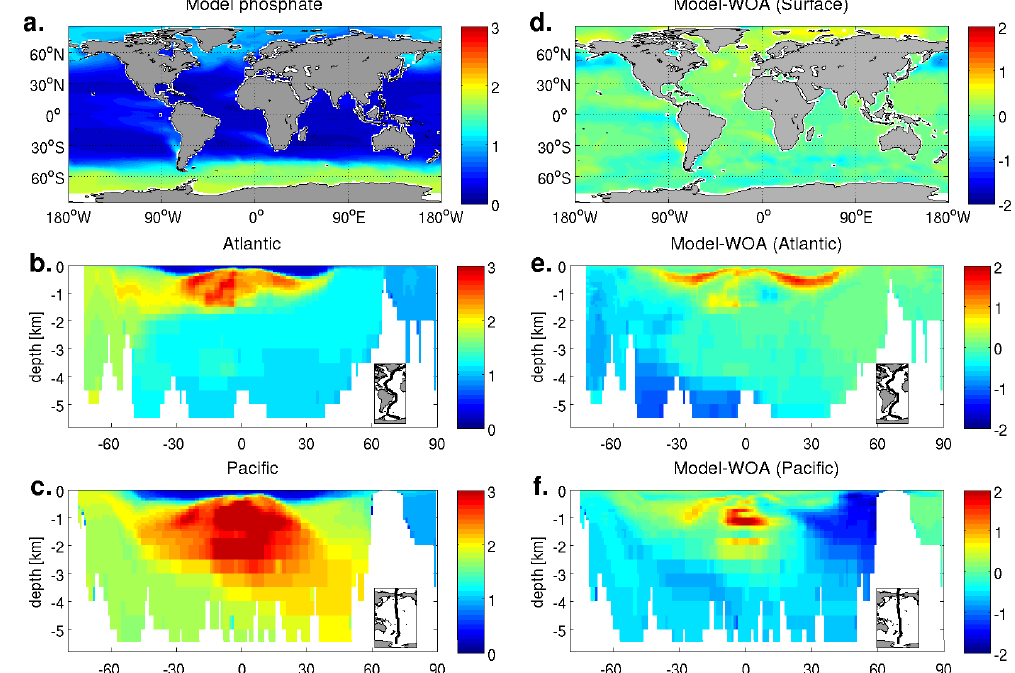
Fig. 6. Distribution of dissolved phosphate concentration from model simulation (left) and difference between the model and climatological estimates (right) (WOA, Garcia et al., 2010b) for the surface (a, d) , Atlantic (b, e) , and Pacific (c, f) vertical sections. Units are in (µmolL − 1